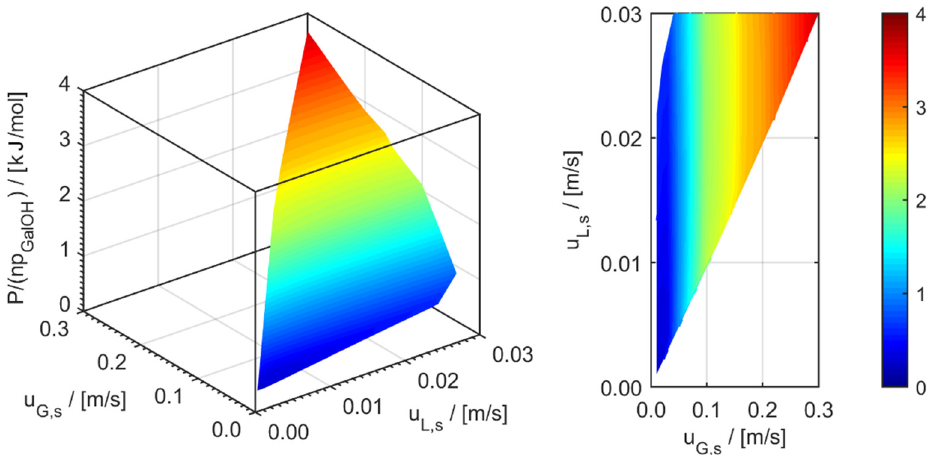
Figure 20. Specific energy consumption of mini trickle-bed reactors operating at different gas and liquid superficial velocities.